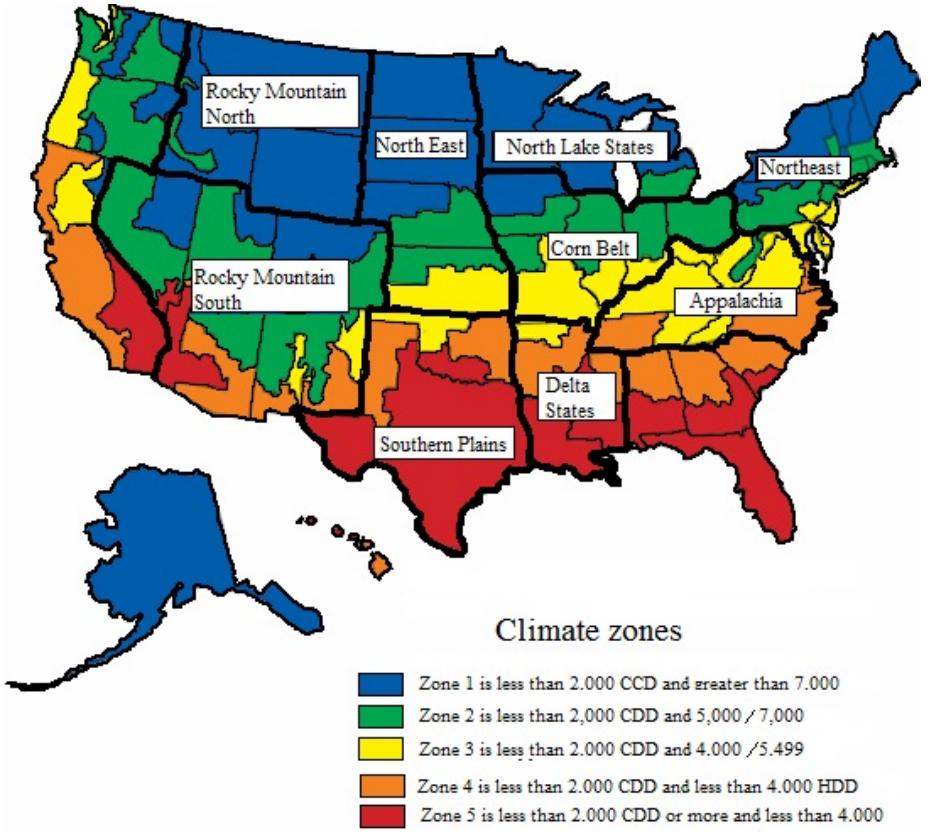
Figure 1. Climate zones in the continental United States. CCD = Cooling Degree Day and HDD = Heating Degree Day, Source: [22].